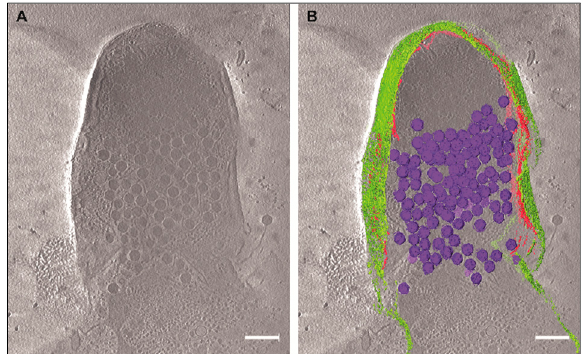
Figure 5. Cryo-electron tomography of M. smegmatis infected with Ms6 Δ lysB at 150 min post- adsorption. ( A ) Slice through the tomogram of an infected cell; ( B ) segmented volume of the phage capsids (purple), cell membrane and PG (magenta) and the outer membrane (green). Scale bar (200